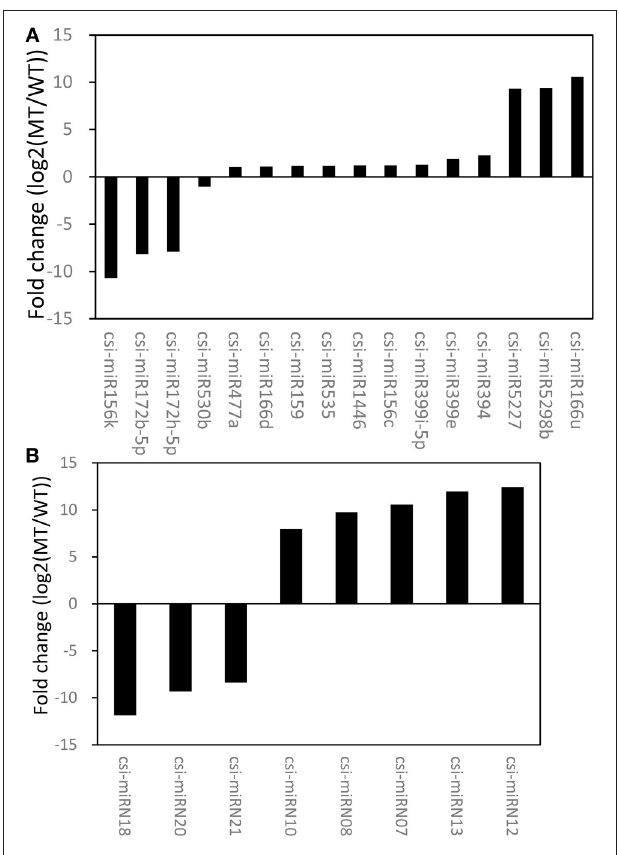
FIGURE 2 | The differentially expressed known miRNAs (A) and novel miRNAs (B) between MT and